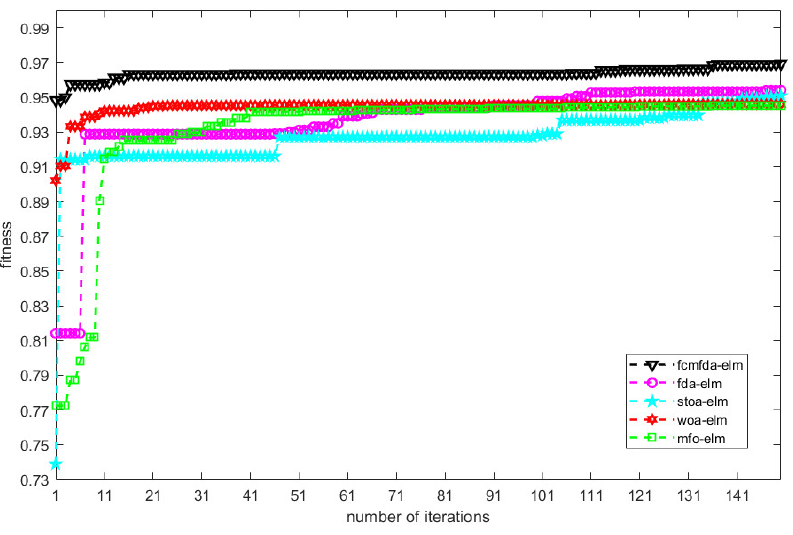
Figure 16. Convergence curve of each classification algorithm